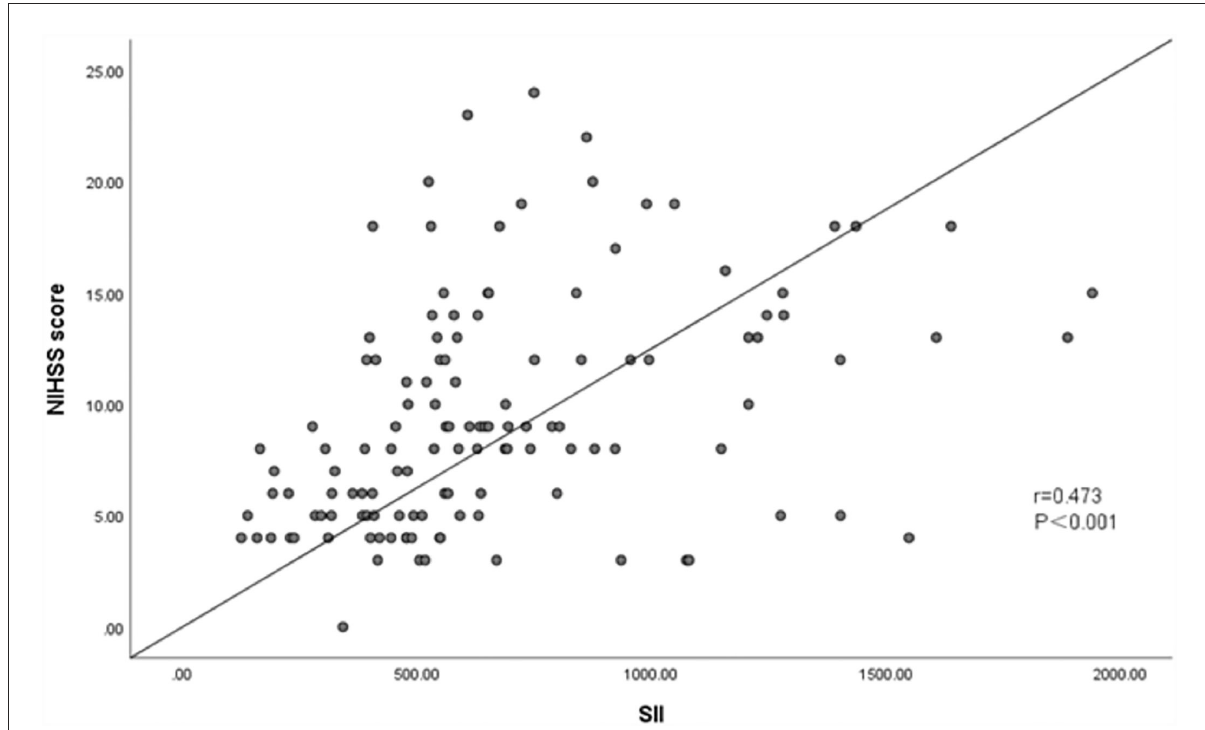
FIGURE5 Association between SII and NHISS score. Spearman test showed that SII was positively associated with NHISS Score ( r = 0.473, P <